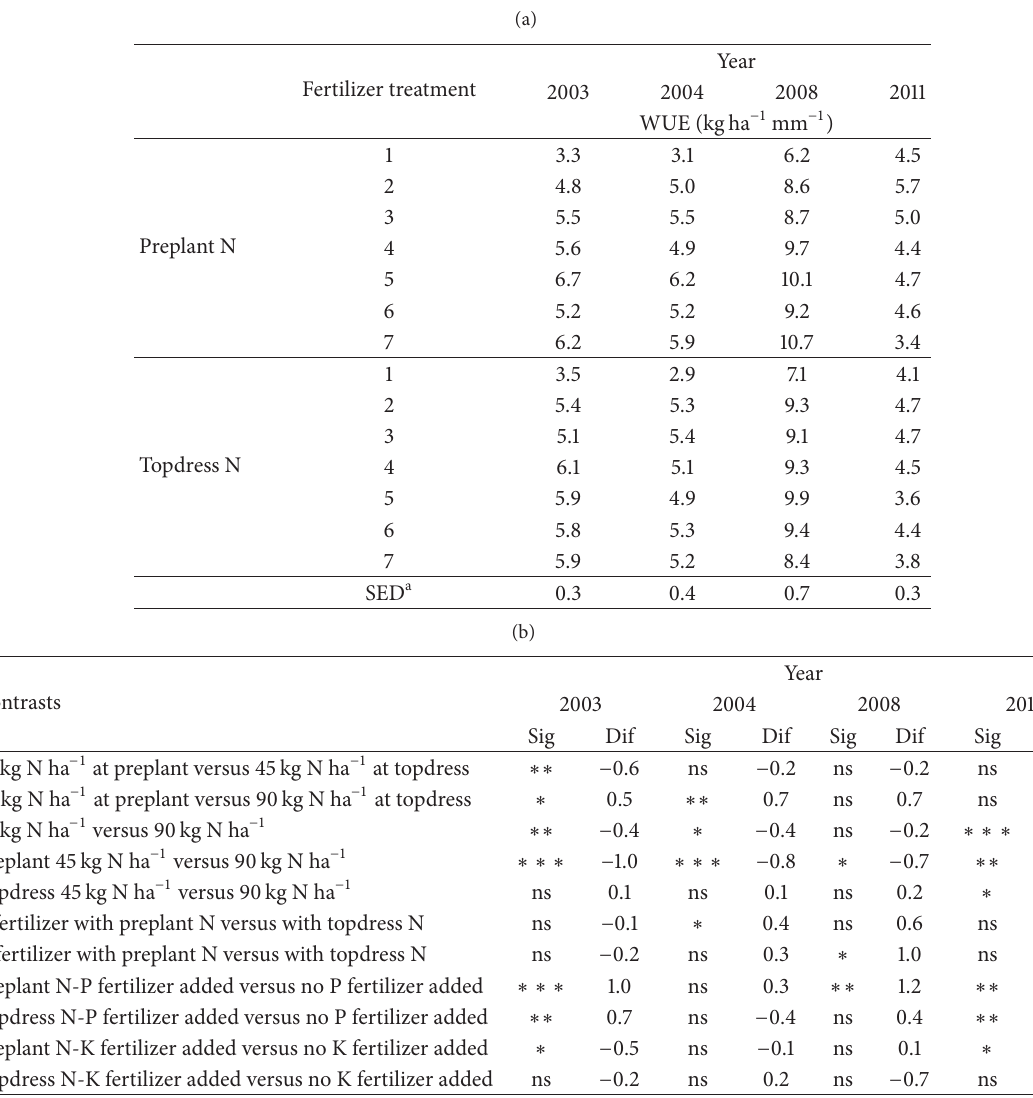
Table 8: Water use efficiency (WUE) means and selected contrasts by year for plots with different fertilizer treatments and those received either their total N fertilizer preplant or topdressed midseason.